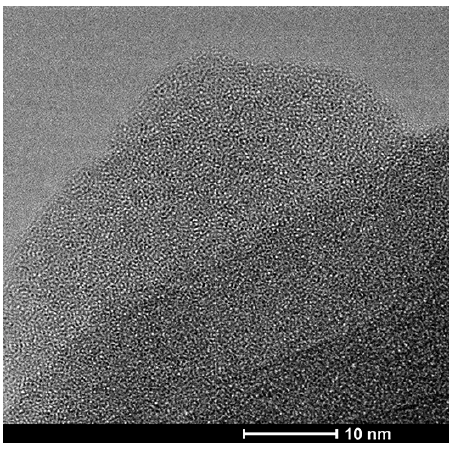
Figure 5. TEM image of the hybrid matrices (sample not imprinted and without GO/Ag NPs).